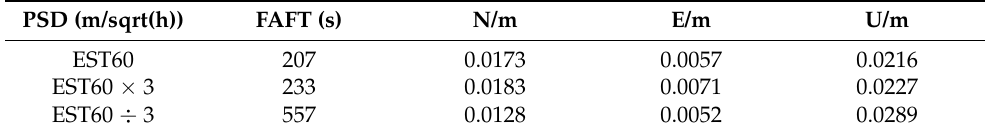
Table 5. The FAFT and the Positioning Precision of Baseline C with the estimated PSD.